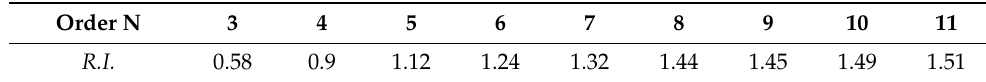
Table 2. Table of random